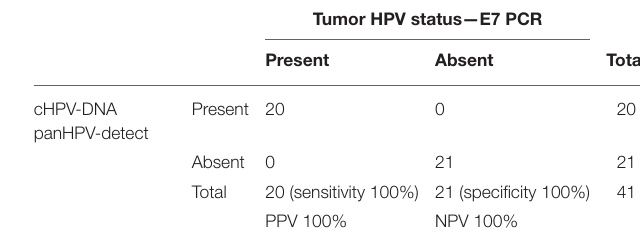
TABLE 3 | Comparison of HPV status using E7 expression in tissue and pan HPV-detect in baseline